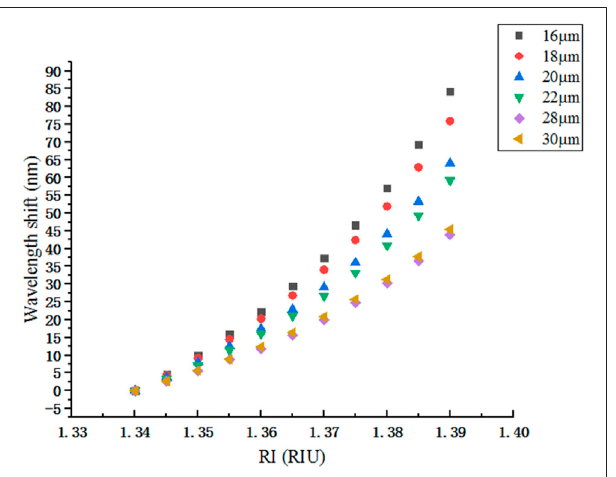
FIGURE 7 | Wavelength shift of D core variation when L 2 (cid:2) 6.80